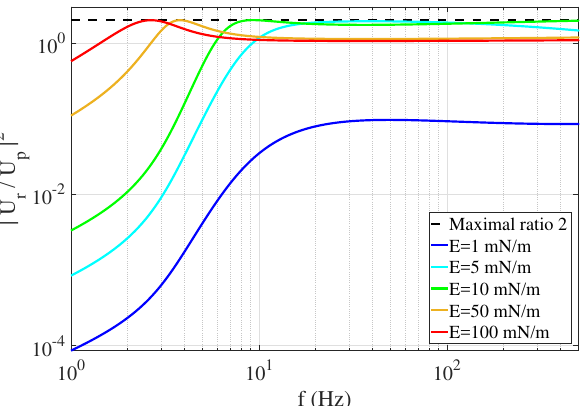
Figure 4. Square of the ratio of the rotational velocity on the potential velocity due to the elasticity of a surfactant contaminated free surface, using Equation (66) according to the model proposed by Ermakov [60], as a function of the frequency of the surface wave for a few values of the film elasticity E . The maximum value of 2 of this ratio is reached when the Marangoni waves are resonantly excited by the surface